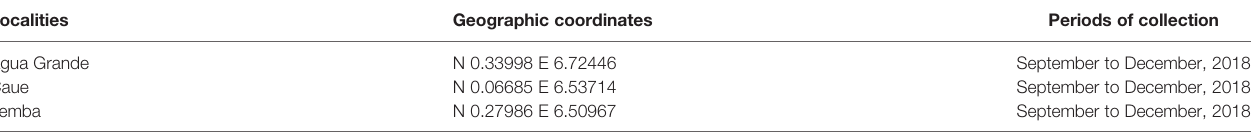
TABLE 1 | Characteristics of study sites.